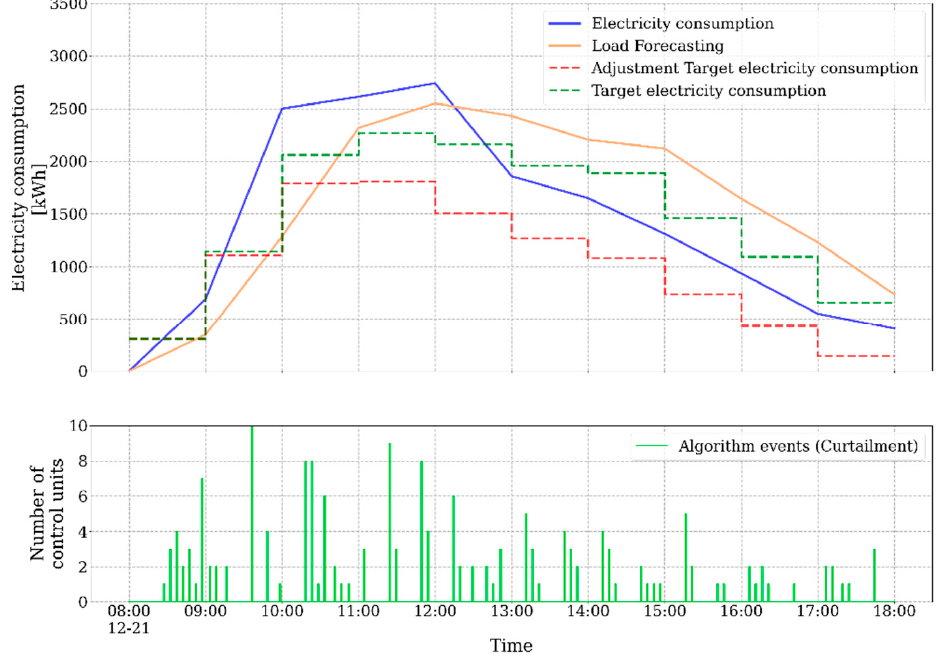
Figure 18. Reduction ratio 10% result of the field test with the target, building electricity consumption, and algorithm events applying the building control algorithm.